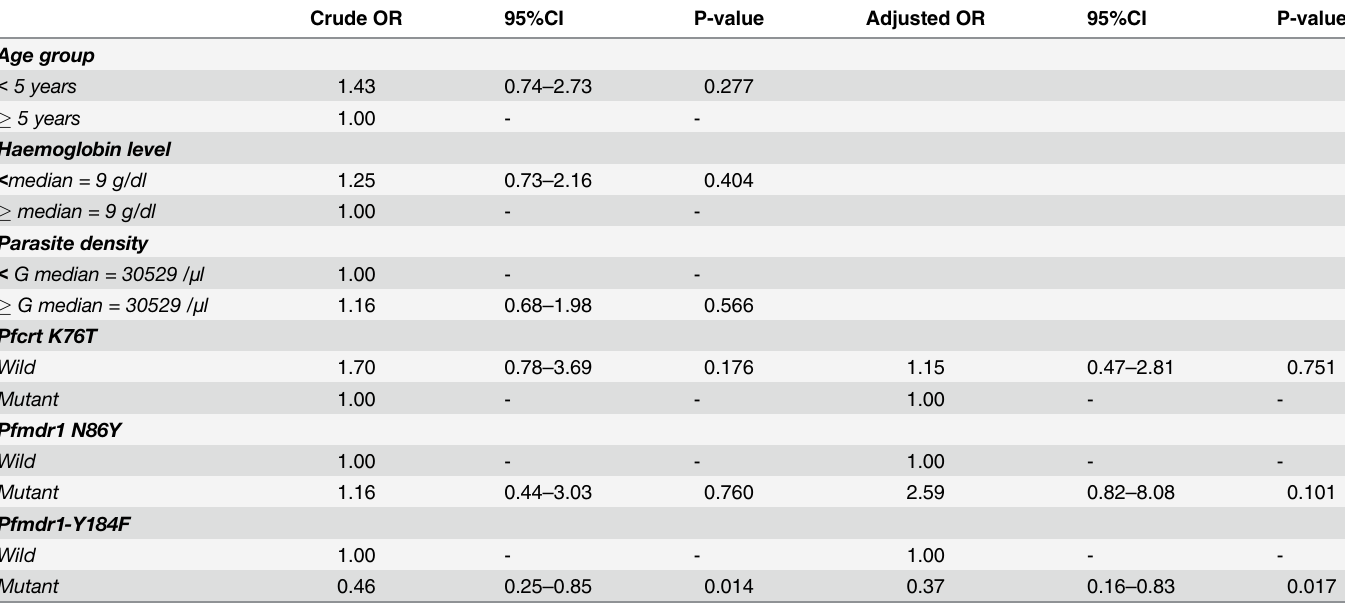
Table 3. Multivariate analysis of the association between SNPs in Pfcrt and Pfmdr1 genes and AL treatment failure. Crude OR 95%CI